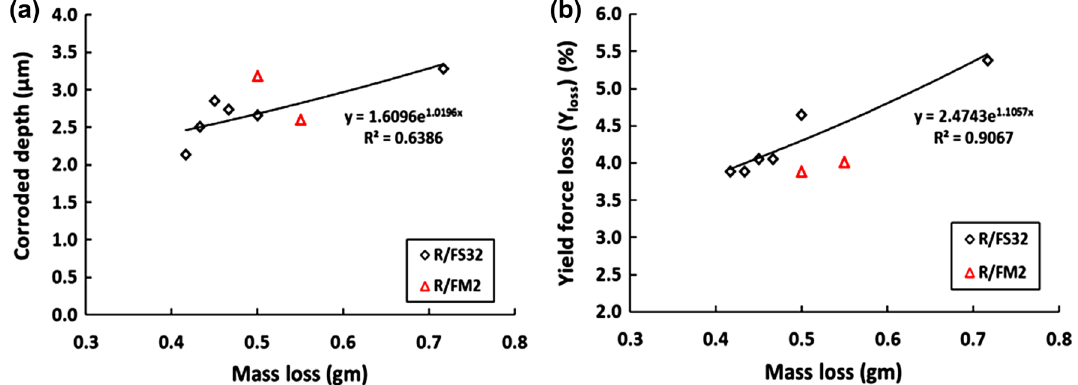
Fig. 18 Measured corroded depths and actual mass loss of steel bars of R/FS32 and R/FM2